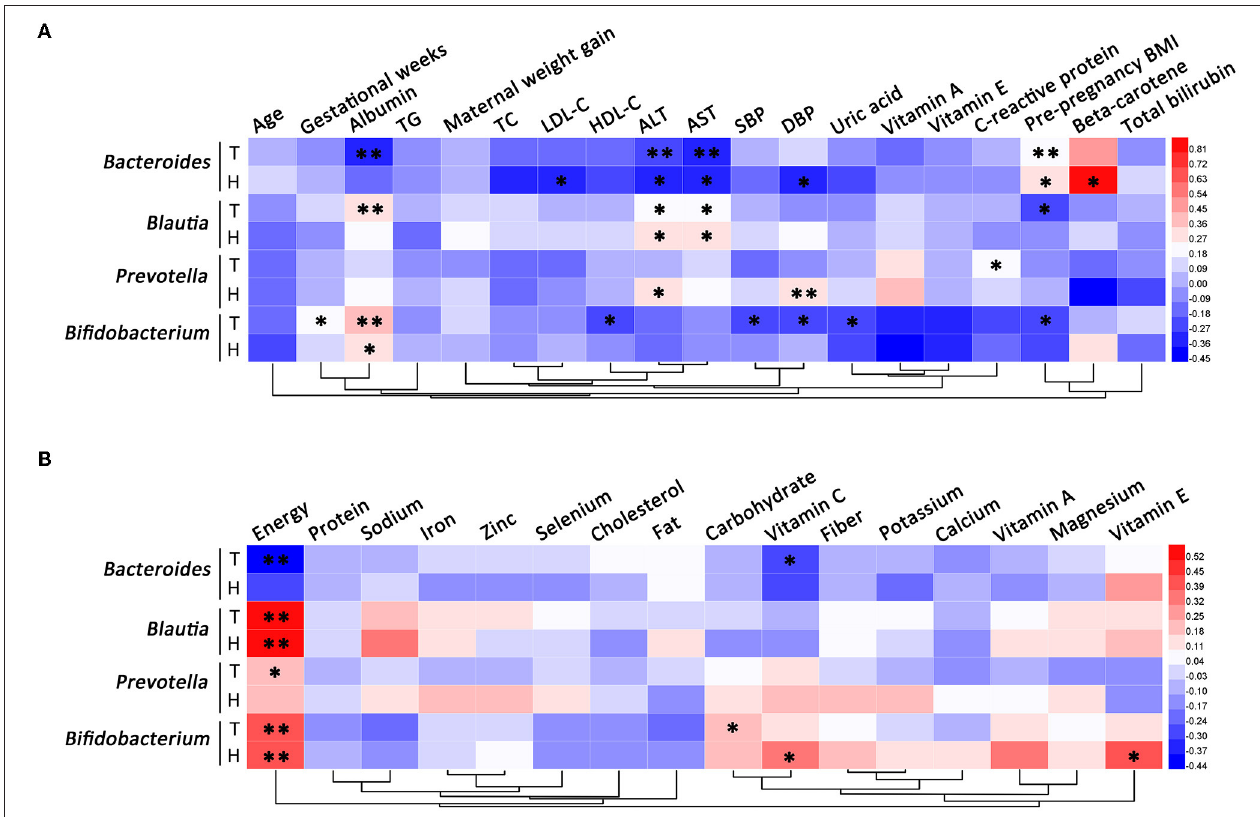
FIGURE 7 | Correlation analysis of differential gut microbial genera. (A) The correlations between differential gut microbial genera and clinical characteristics. (B) The correlations between differential gut microbial genera and dietary nutrient intakes. T, total; H, HDP. * P < 0.05, ** P < 0.01.